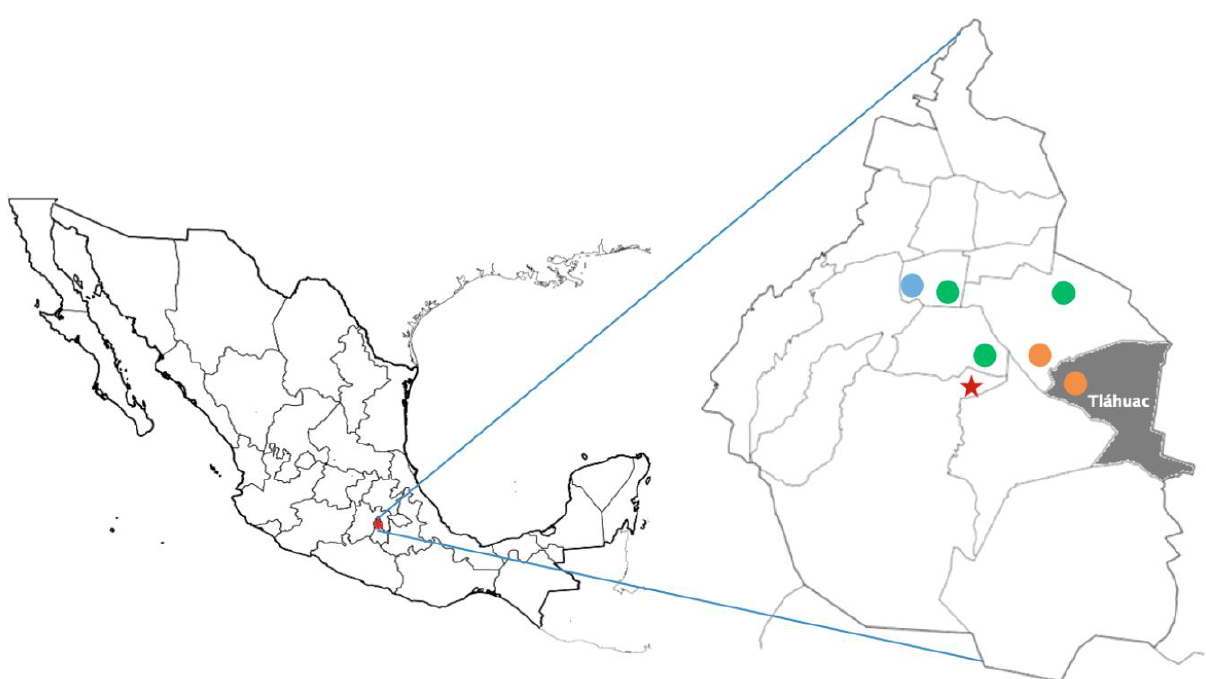
Figure 1. Map of Mexico ( left ), and a map of Mexico City ( right ). The BASIT study was performed in Tláhuac municipality (gray zone), which is located in the Mexico City. Orange, green, and blue circles represent the hospitals from the Secretaría de Salud, the Instituto Mexicano del Seguro Social, and the Instituto de Seguridad y Servicios Sociales de los Trabajadores del Estado, respectively. Red star: the location of the Instituto Nacional de Ciencias Médicas y Nutrición Salvador Zubirán.